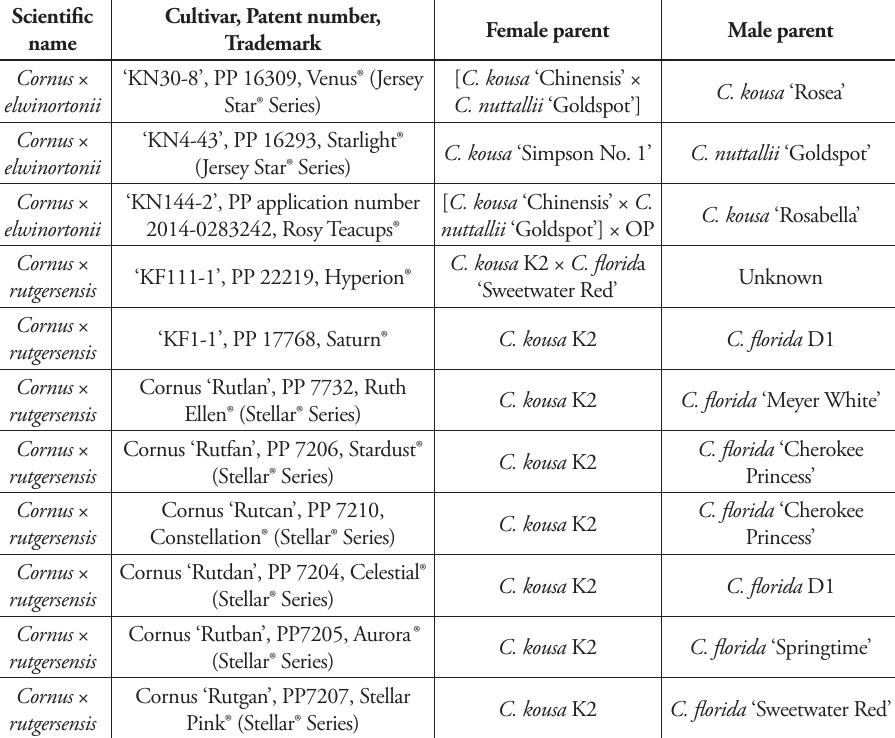
Table 1. Parentage of the eleven interspecific hybrids released from the Rutgers University dogwood breeding program. PP refers to plant patent number. OP indicates open pollination. Brackets ([ ]) contain pedigree information of an interspecific hybrid